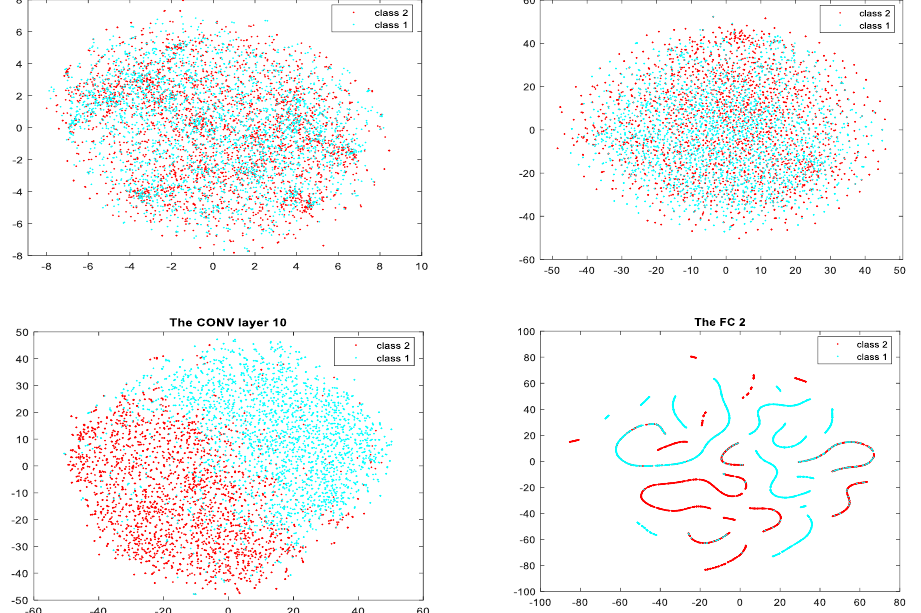
Figure 11. The T-Sen chart of the proposed method for two-class scenarios for F3 and C3 channels.